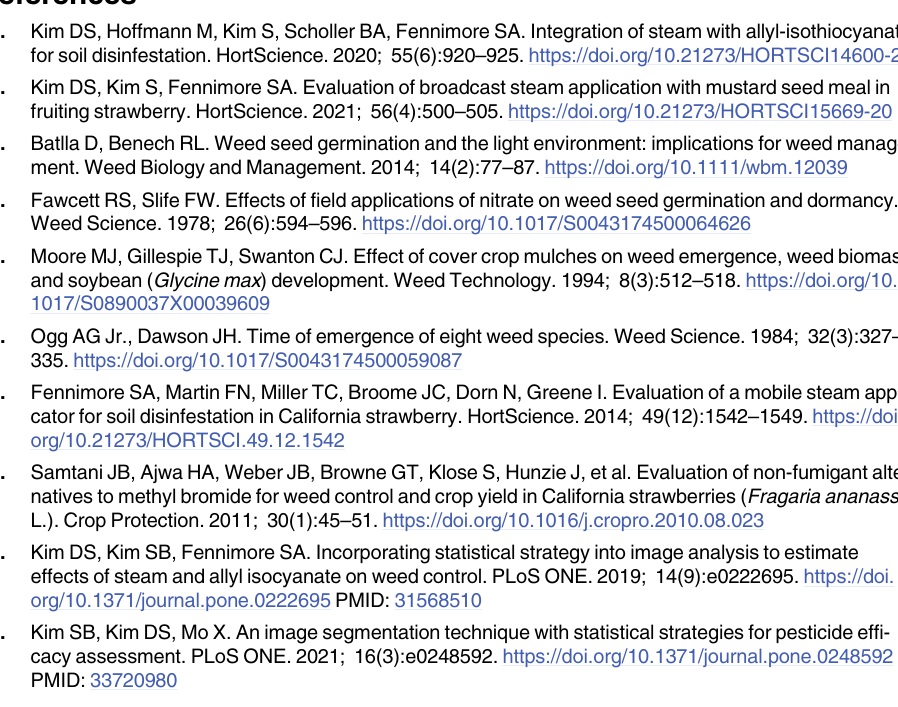
S2 Data. Data observed after the second phase of the experiment (combined with the first